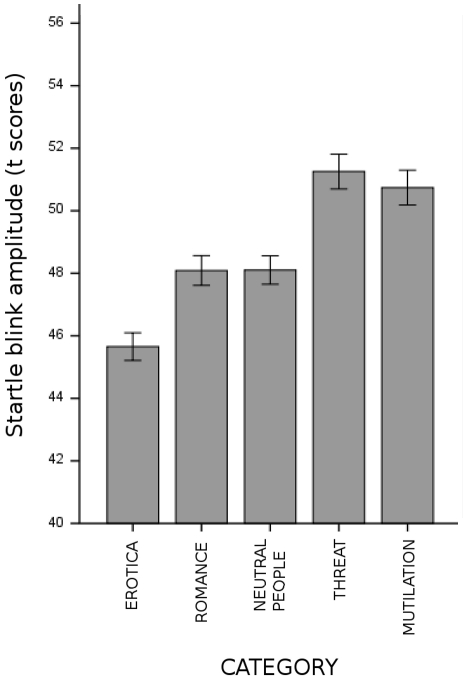
The effects of picture category on the startle eyeblink.Error bars represent standard errors. Magnitude of the startle eyeblink varied with picture valence, being potentiated by unpleasant contents, and inhibited by pictures of erotic couples.